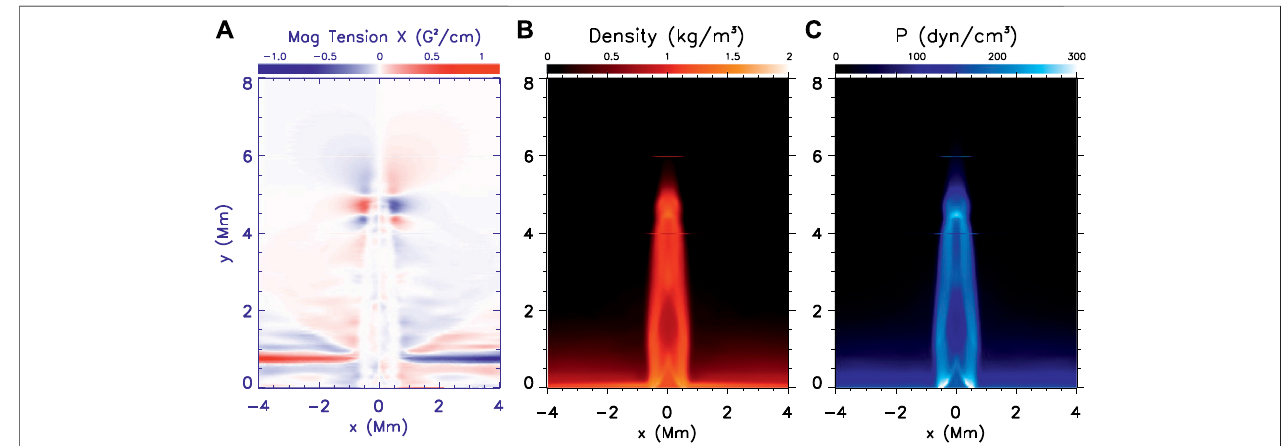
FIGURE 14 | The results of a numerical simulation studying the morphology of a jet in a strati fi ed solar atmosphere with a vertical uniform magnetic fi eld. (A) : distribution of magnetic tension; (B) : density; (C) : pressure.